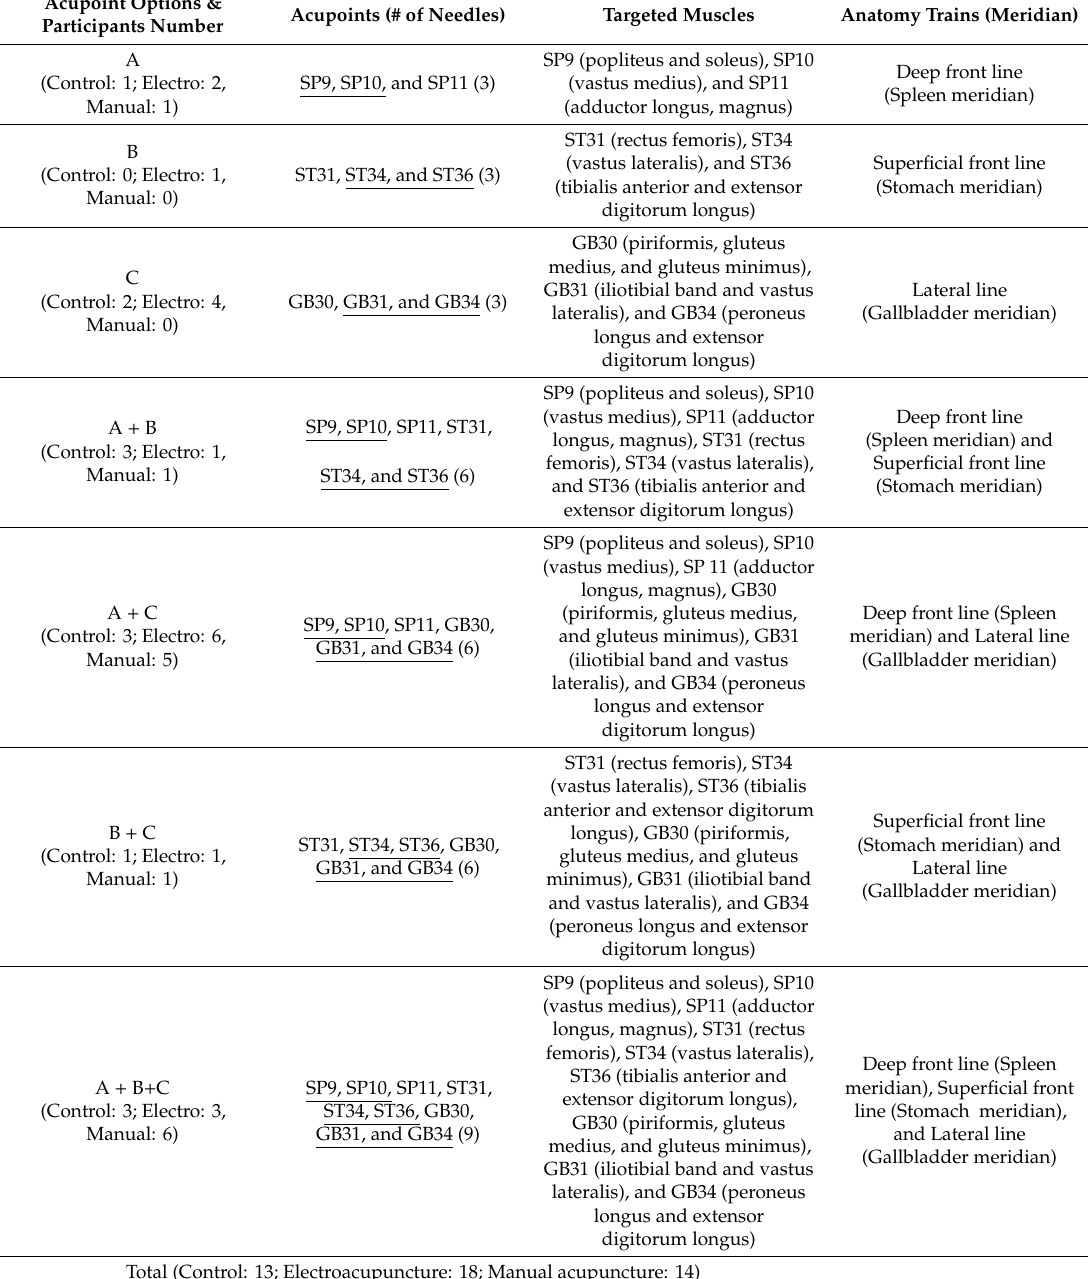
Table 1. Acupoint options, number of participants, acupoints, targeted muscles, and anatomy trains